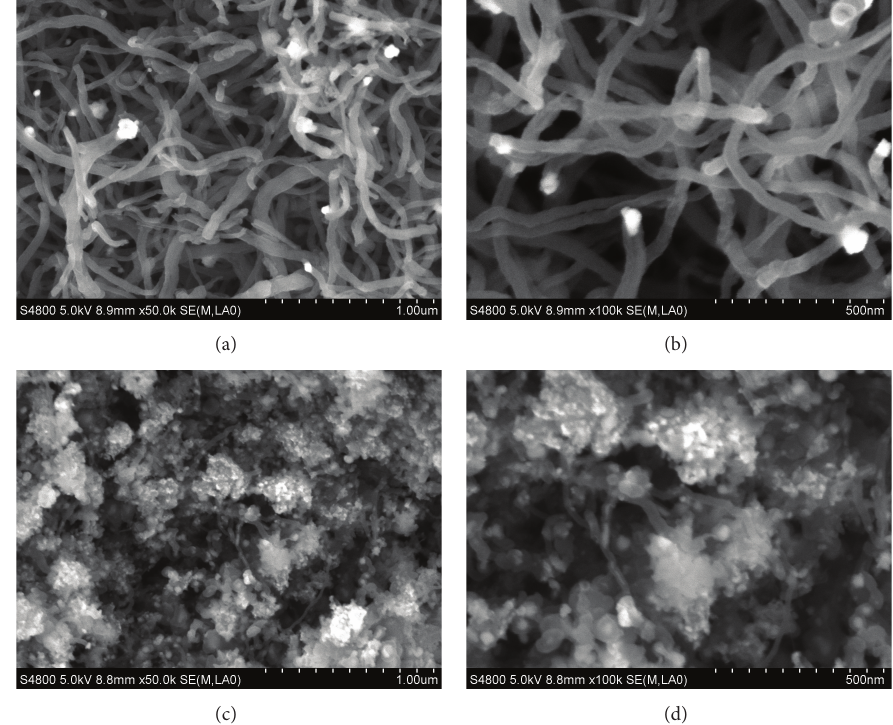
Figure 6: SEM images of as-produced materials grown on the catalysts (a), (b) Ni-Cu/MgO and (c), (d) Ni/MgO calcined at 500 ∘ C with reaction temperature of 650 ∘